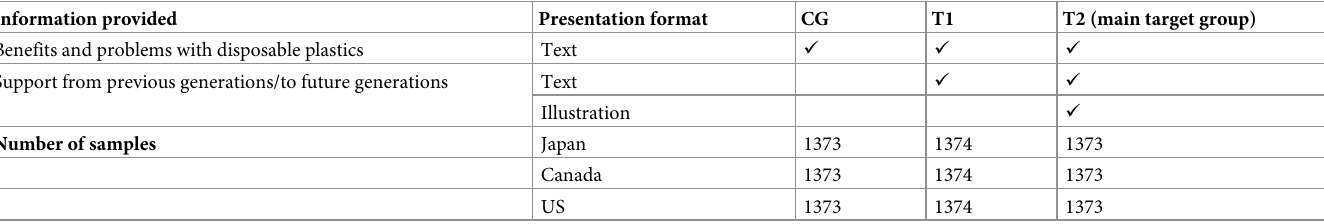
Table 3. Summary of